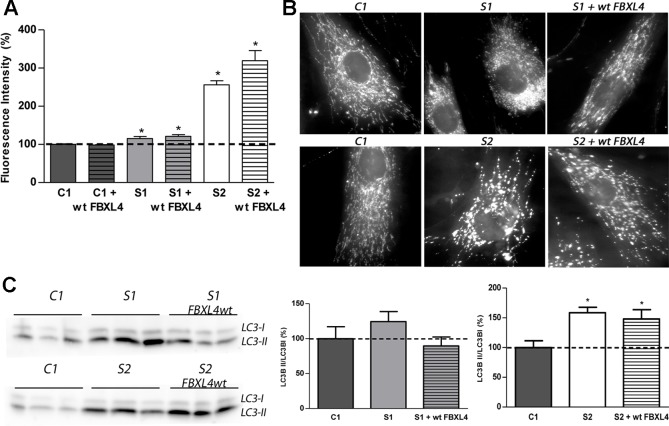
Mitochondrial network shape and size, and autophagy detection. (A) Quantification of mitochondrial mass. Bars represent the mean fluorescence values relative to the mean value of age-matched control fibroblasts in percentage (C1, dotted line, 100%). *: p < 0.05 (vs. C1 cells). (B) Mitochondrial networks of control and patients fibroblasts. Fluorescence microscopy representative images of cells obtained from control and patient fibroblasts and of those transduced with the wt-FBXL4 expressing construct, as indicated. (C) Quantification of autophagy marker LC3-II. WB-immunodetection of the LC3B isoforms (LC3B-I and LC3B-II) of total cell homogenates, and ratio LC3B-II/LC3B-I obtained by quantification of the respective WB-band intensities. The bars represent the mean value, in percentage, compared to that of control fibroblasts (dotted line, 100%). *: p < 0.05 (vs. C1 cells).